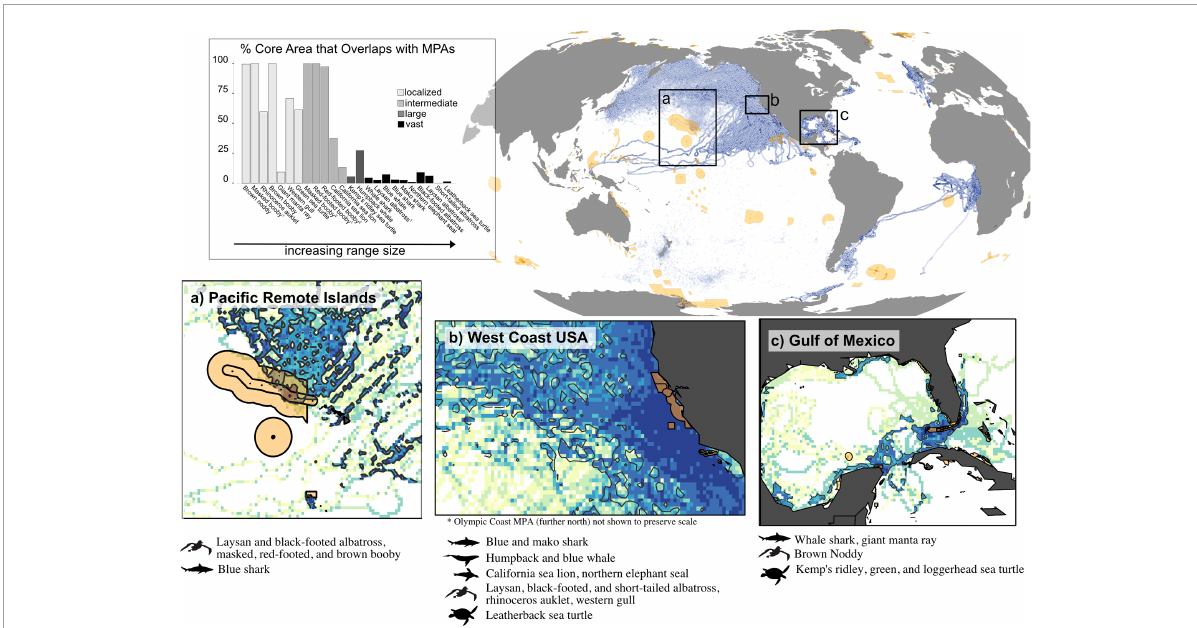
FIGURE 4 Global distribution of MPAs greater than 100 km 2 (orange polygons) and animal tracking datasets (blue points). Insets ( A-C) display regions that contained overlap of MPAs and the home ranges of at least five species. For these regions, gridded utilization distributions (UDs; shown in insets) were calculated on a normalized species aggregate; contours of the core UDs of the species aggregate are outlined in black. The inlaid barplot demonstrates a sharp decrease in coverage of mobile marine taxa with increasing home range size, particularly when transitioning from ‘intermediate’ to ‘large’ home range area. Species whose ranges did not overlap with existing MPAs in the case study regions are not